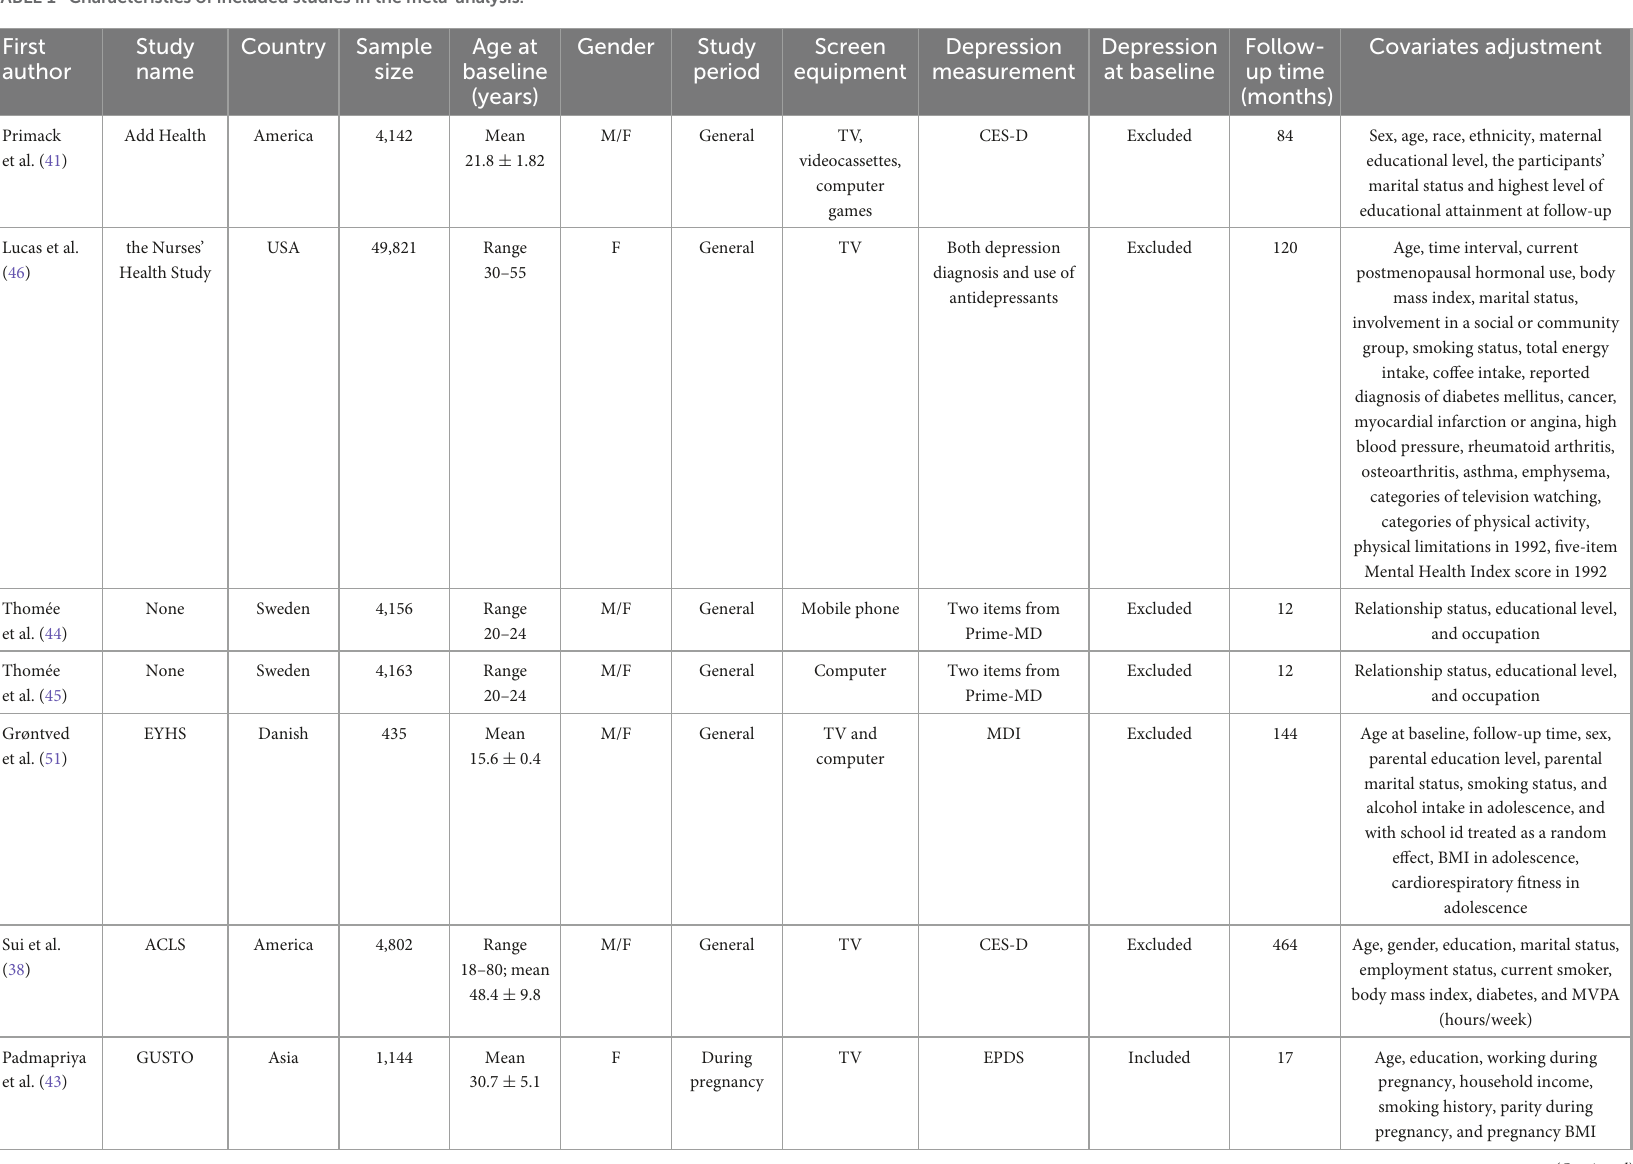
TABLE 1 Characteristics of included studies in the